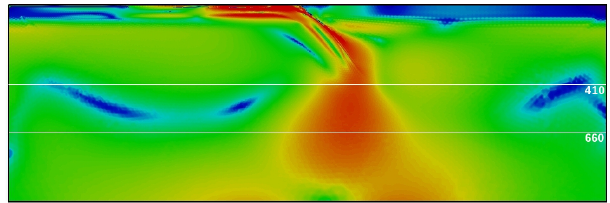
Fig. A1. Energy dissipation for the model with open boundaries and aspect ratio 3:1 at time = 3.5My.